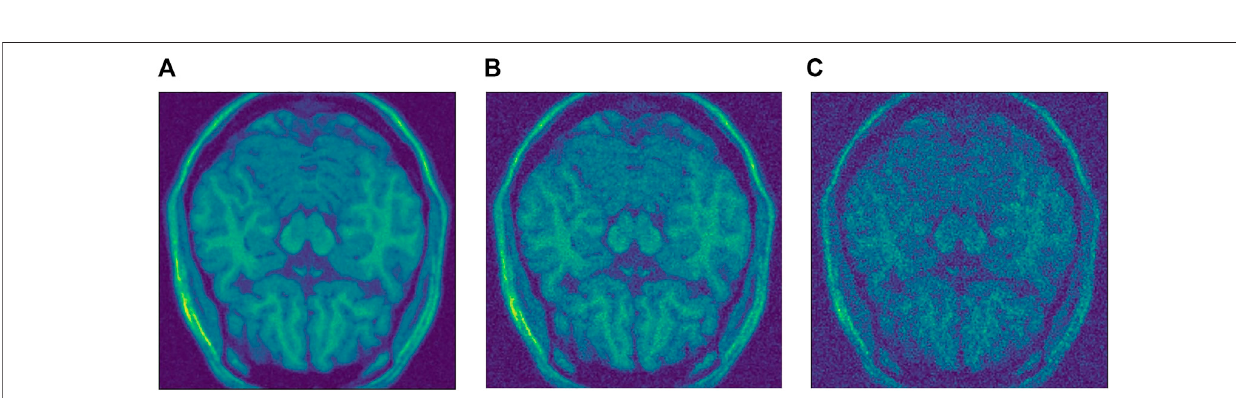
FIGURE 3 | Different levels of noise. (A) Low level σ (cid:1) 50. (B) Medium level σ (cid:1) 100. (C) High level σ (cid:1) 200.